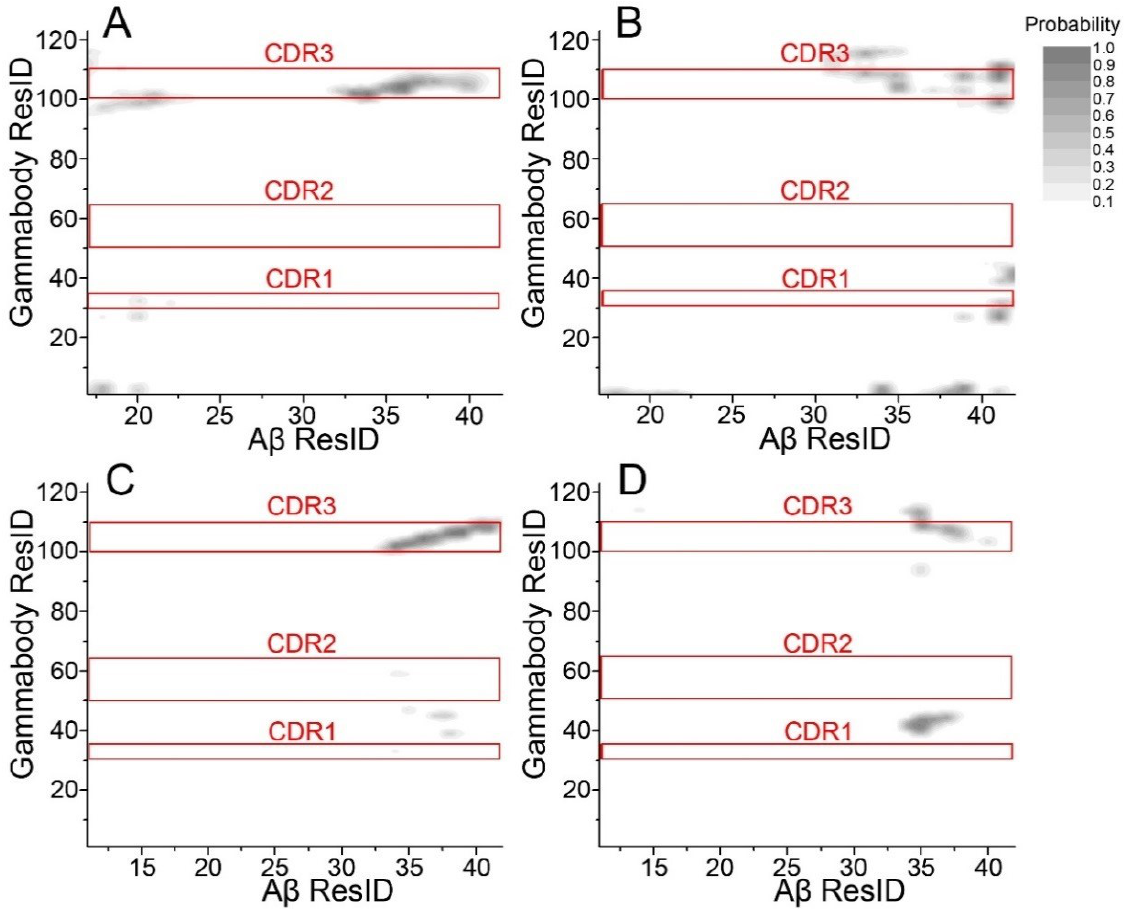
Figure 4. The gammabody mainly uses the CDR3 to interact with A β amyloid, while there is no contributions from the CDR1/CDR2 residues. Residue contact maps for ( A ) 2U_Backbone; ( B ) 2U_SideChain; ( C ) 3S_Backbone; and ( D ) 3S_SideChain complexes. Two residues at